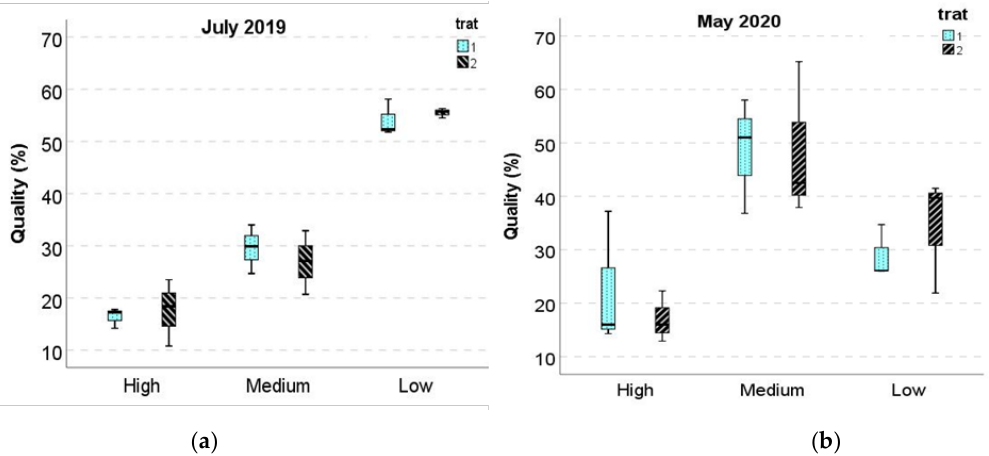
Figure 5. Box plot of cob quality expressed in % weight of each class respect to total weigh for each treatment and date (treatment • cob quality interaction was not significant). ( a ): data from the first harvest (2019) and ( b ): data from the second harvest (2020).